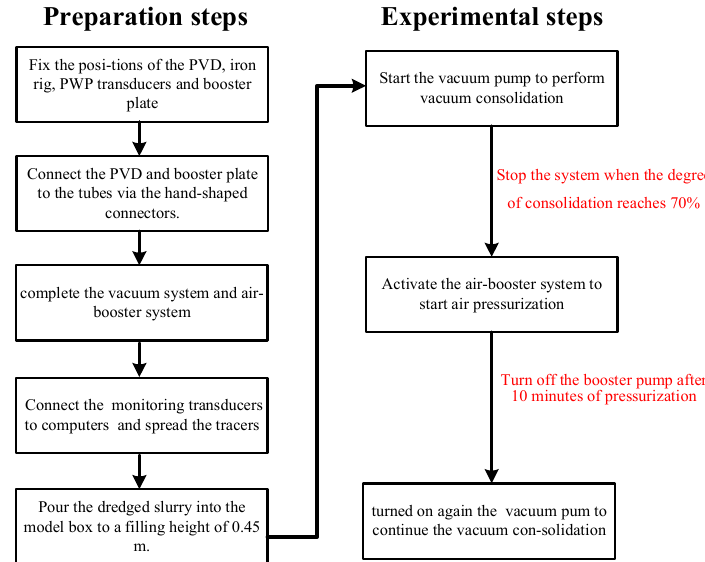
Figure 5. Flow chart of test operation procedures.